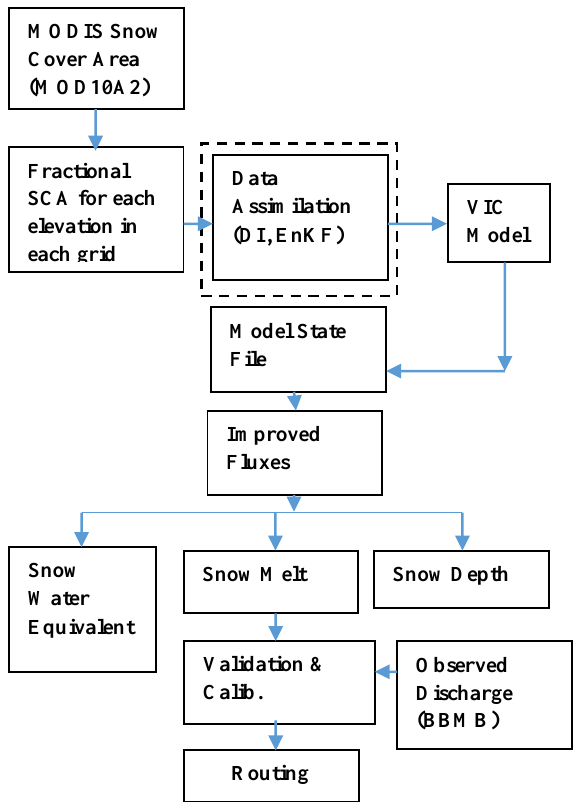
Figure 3.2. Data Assimilation flow